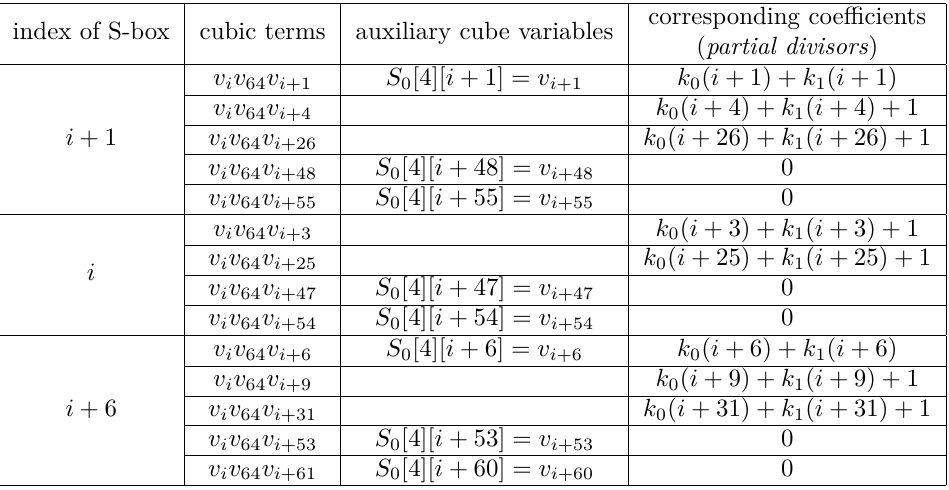
Table 5: Coefficients of Cubic Terms with Auxiliary Cube